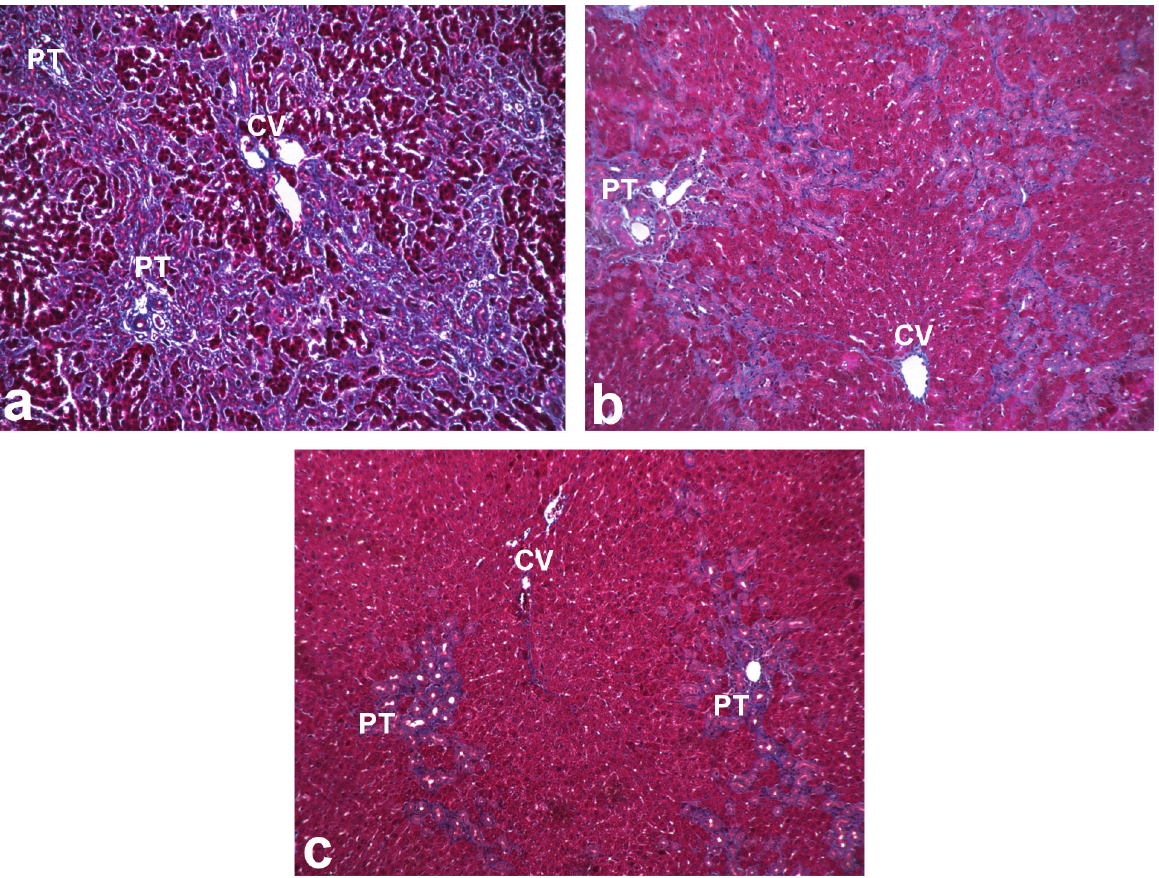
Figure 2 - Semiquantitative evaluation of fi brosis in the experimental groups after 6 weeks of BDL. a ) Group Bdl; b ) Group Bdl+Am ; c ) Group Bdl+Am . Portal tract (PT); Central Vein (CV). Masson’s trichome staining with a magnifi cation of 100 x. 0 1